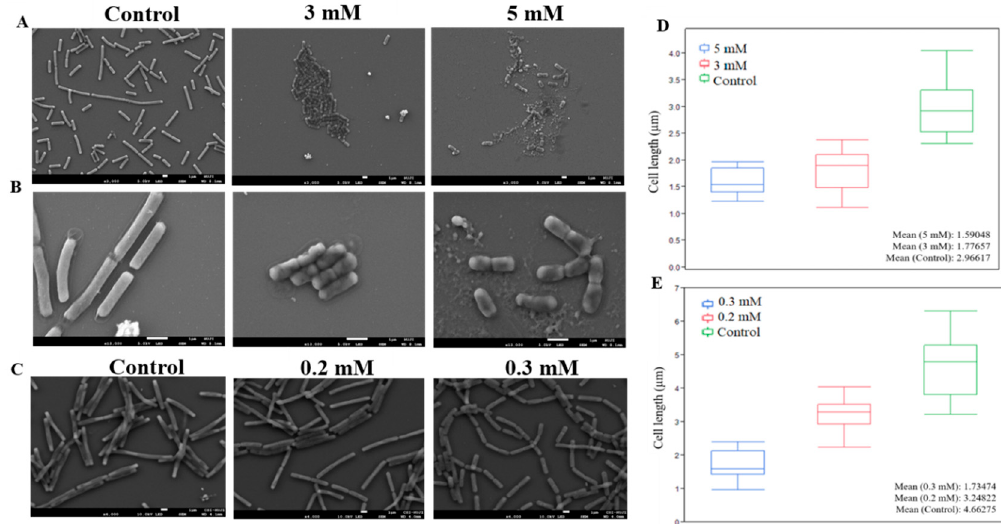
Figure 4. Zn 2+ ions restrict elongation in B. subtilis cells. Scanning (SEM) images of B. subtilis cells following 4 h exposure to ZnCl 2 in concentrations of 3 mM and 5 mM showing inhibition of cell elongation and abnormalities in cells shape. Overnight exposure to ZnCl 2 in concentrations of 0.2 and 0.3 mM affected cell elongation. Images shown were taken at magnifications of ×3000 ( A ), ×13,000 ( B ) and ×4000 ( C ) with a Jeol JSM ‐ IT ‐ 100 LV at 5.0–10.0 kV. Box plot graph displaying differences in cell size caused by exposure to 5 and 3 mM ( D ) or 0.2 and 0.3 mM ZnCl 2 ( E ).